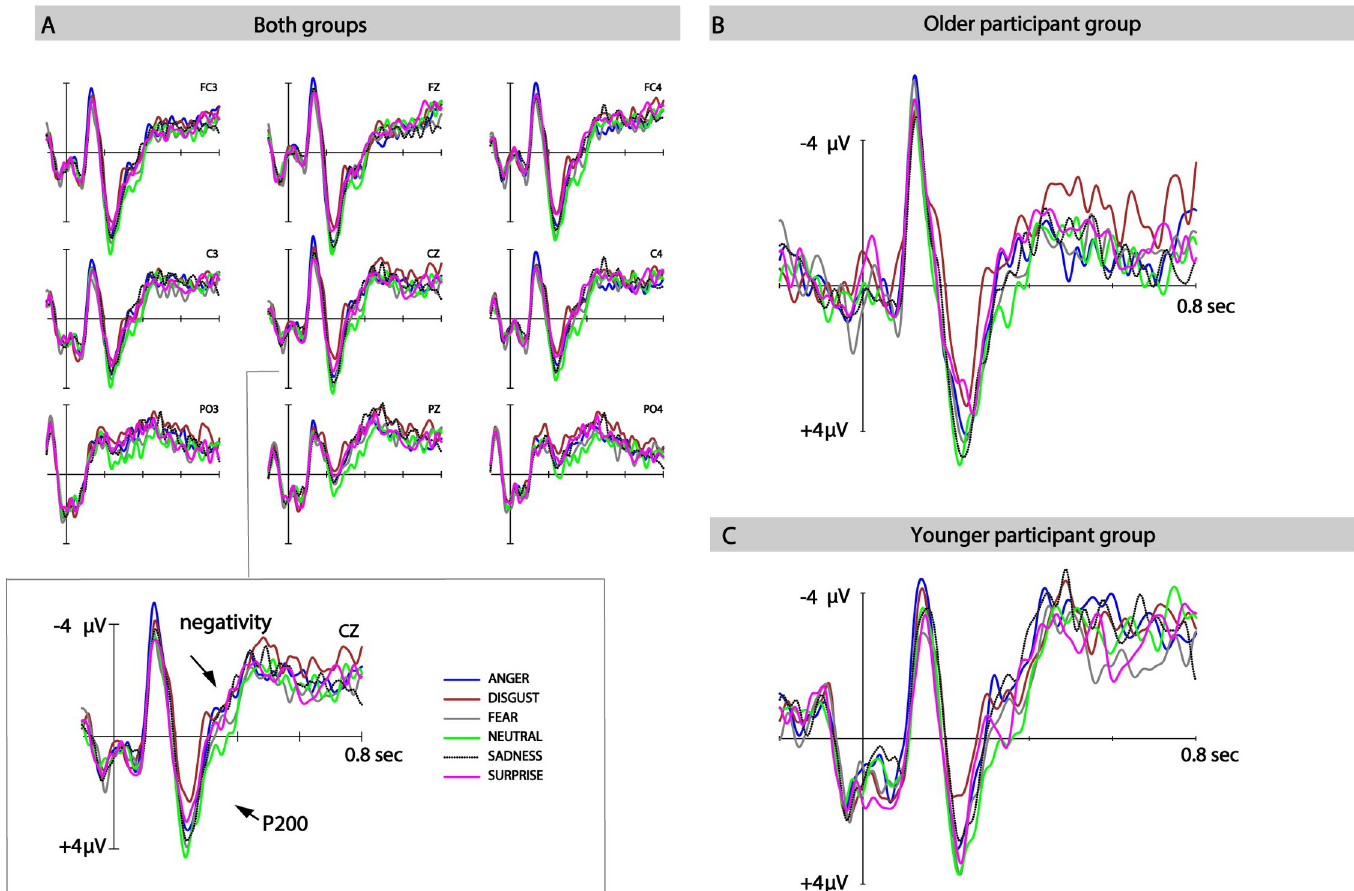
Fig 2. ERP mean amplitude of the younger and older groups per emotion category. Zoomed-in on CZ for closer visual inspection of the data.